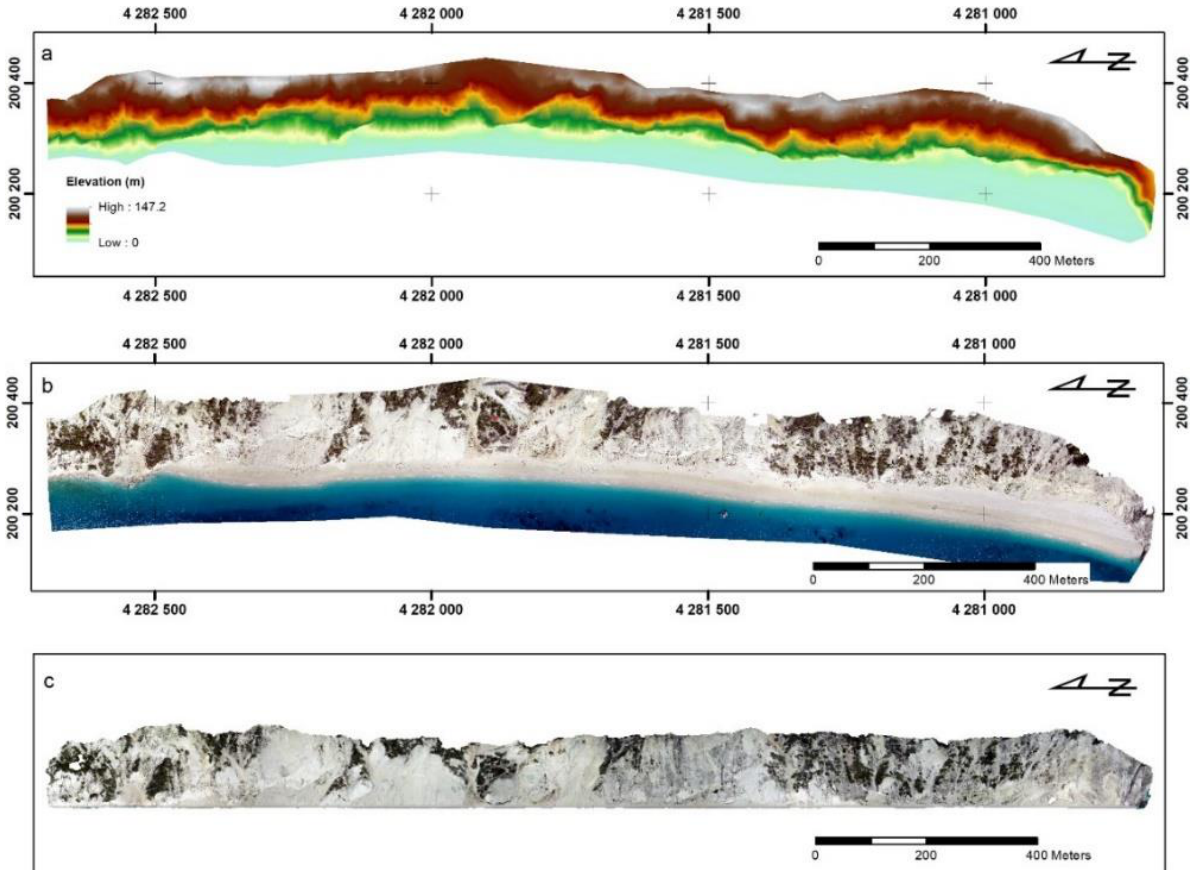
Figure 5. The SfM technique led to the construction of several high-resolution products such as ( a ) DSM, ( b ) ortho-image and ( c ) vertical photo-mosaic of the Egremnoi steep slope.